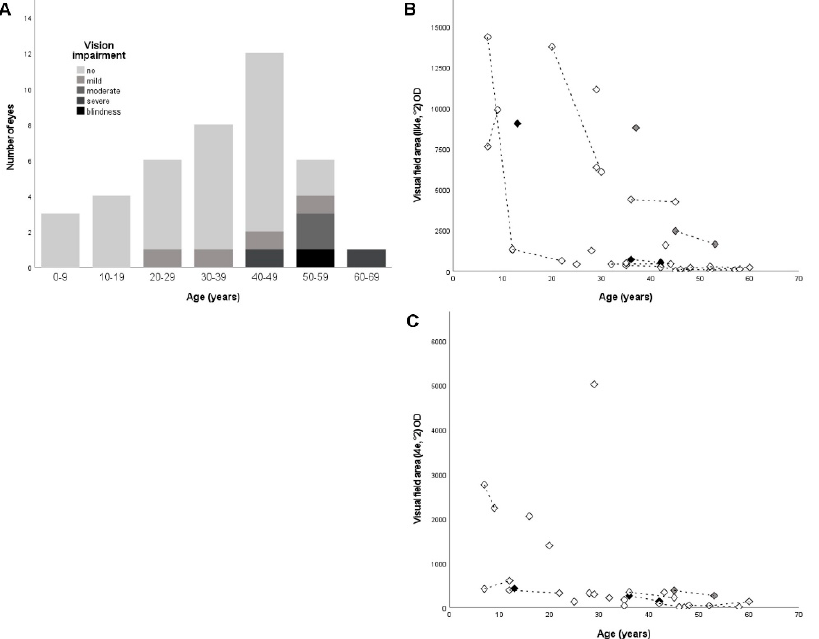
Figure 2. Visual acuity and kinetic visual field in PDE6B -associated retinitis pigmentosa. (A) Best-corrected visual acuity (BCVA) in right eyes (first visit and follow-up) with respect to age/disease duration. Notably, the BCVA was good until the end of the fourth decade in our cohort. (B) Kinetic visual field (VF) area obtained with target III4e of Goldmann in right eyes with respect to age/disease duration. Follow-up is indicated by the dashed lines. Note the large(r) loss of visual field (VF) area before the age of 30, which reflects the natural course of the disease. (C) VF area obtained with target I4e in right eyes with respect to age/disease duration. Follow-up is indicated by the dashed lines. Note the outlier, which is the patient in which dark-adapted 3.0 cds/m 2 full-field electroretinography showed response (SRP-612-17465). Black symbols indicate patients homozygous for the most frequent variant in our cohort, c.892C>T;p.(Q298*), grey symbols indicate patients homozygous for the second most frequent variant in our cohort, c.2326G>A;p.(D776N), and white symbols indicate the other patients with different genotypes.